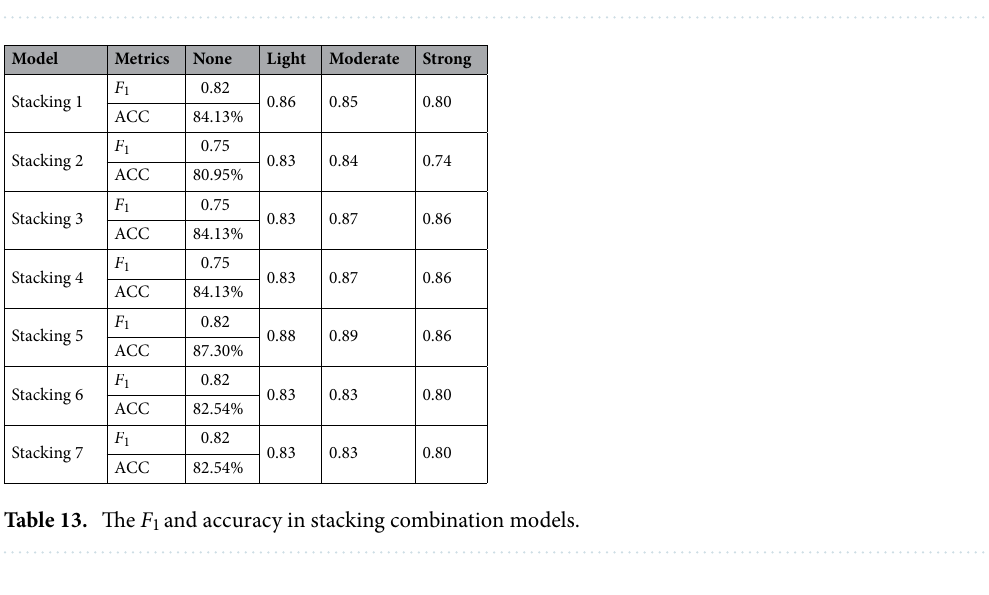
Figure 13. The comparison of F 1 in bagging 1, bagging 4, and bagging 6 and their base classifiers.